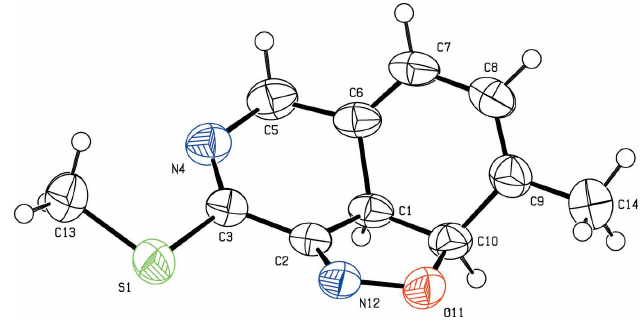
Figure 3 A view of the crystal packing, showing the (cid:2) –ring interactions (dashed lines). The yellow dots are centroids of rings. H atoms not involved in these interactions have been omitted for clarity.